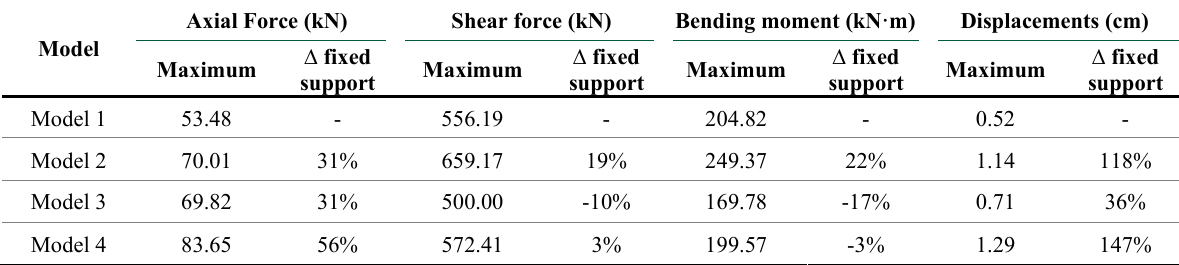
Table 7. Maximum forces on the support beam of wall 41.